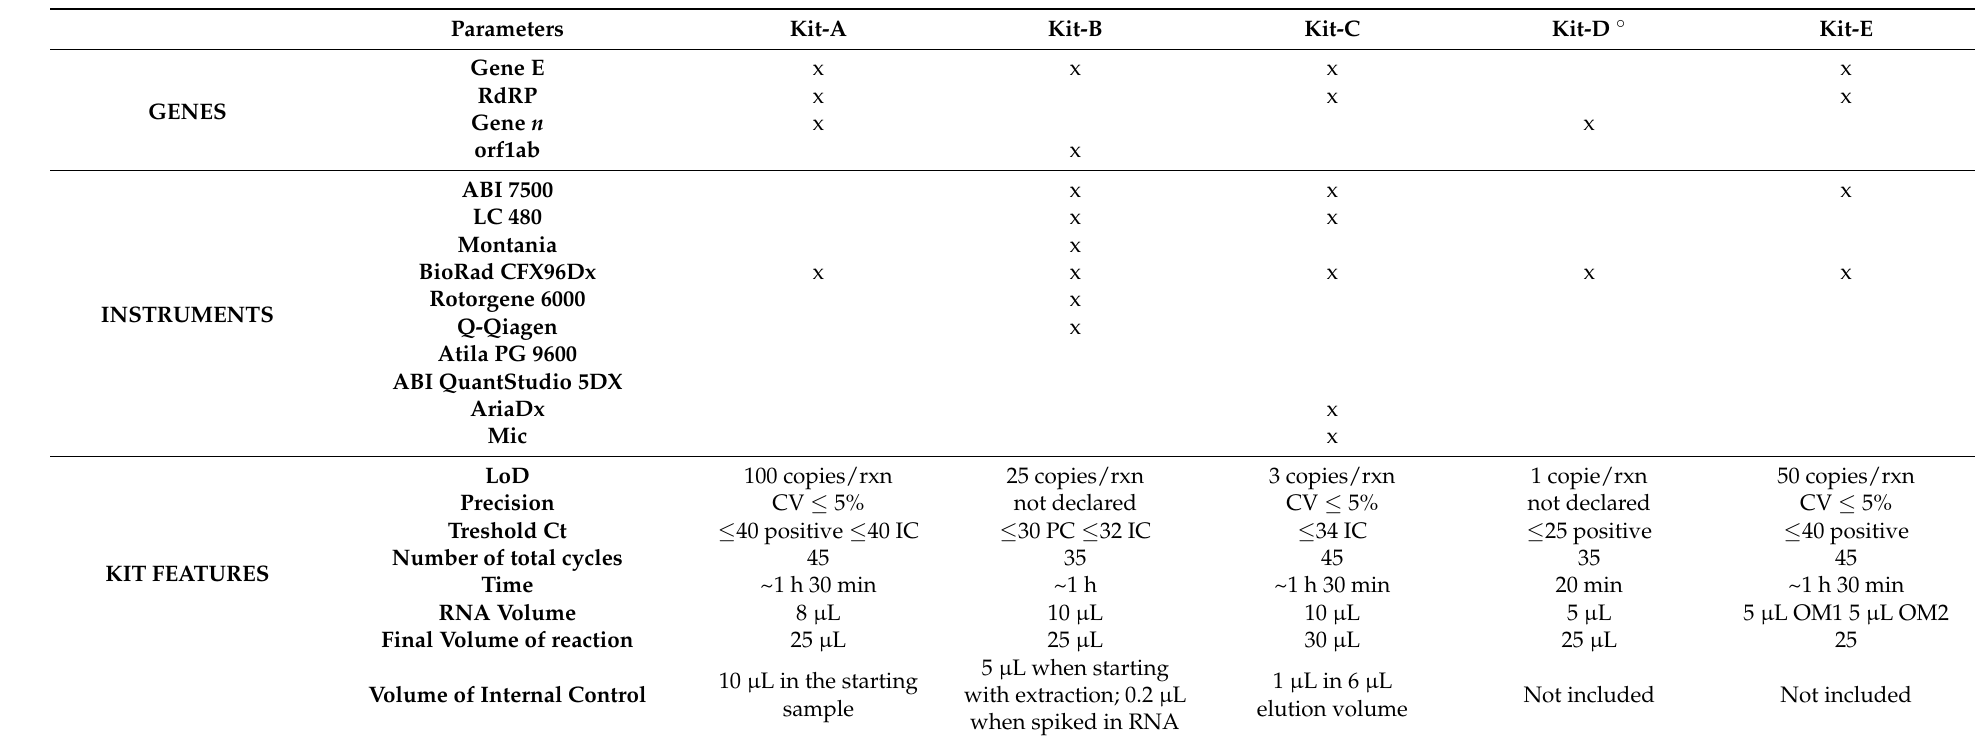
Table 2. Characteristics of the five kits used for the detection of SARS-CoV-2 genomic